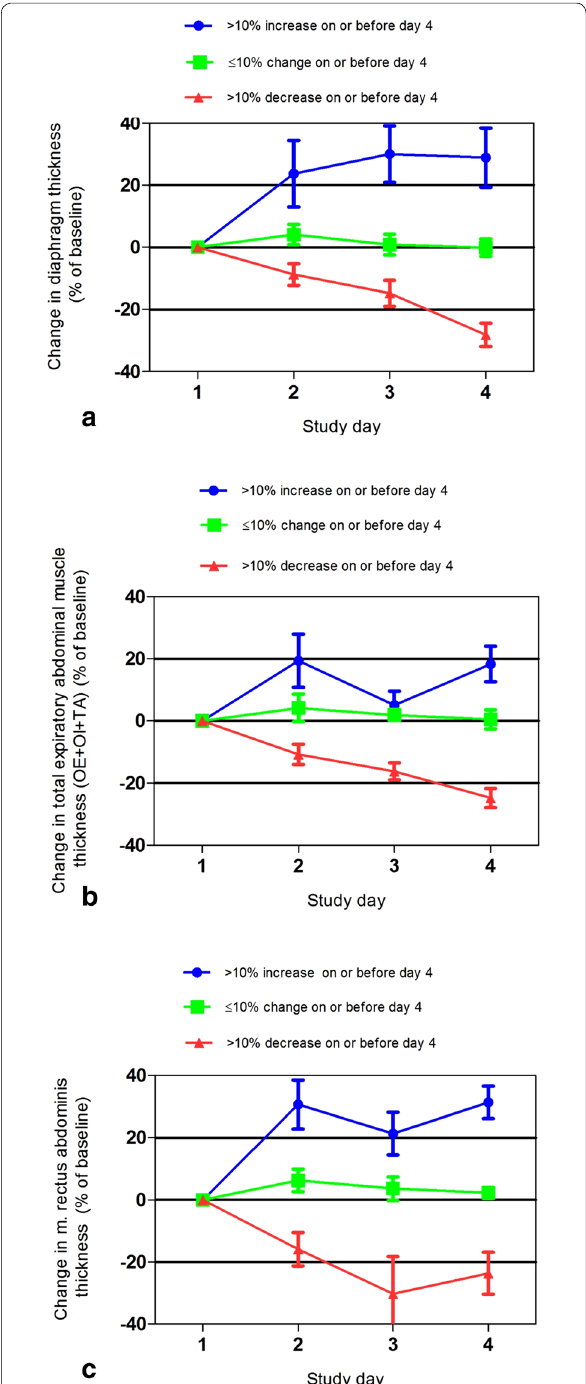
Fig. 2 Change in thickness of the diaphragm muscle ( a ), total expiratory muscles (OE OI TA) ( b ), and m. rectus abdominis ( c ) + + over the first 4 days of mechanical ventilation. Mean and standard error of the mean are plotted for each group and study day. Thickness of the muscles was significantly different between each group for all muscles on day 4 ( P 0.0001). OE , obliquus externa; OI , obliquus ≤ interna; TA , transversus